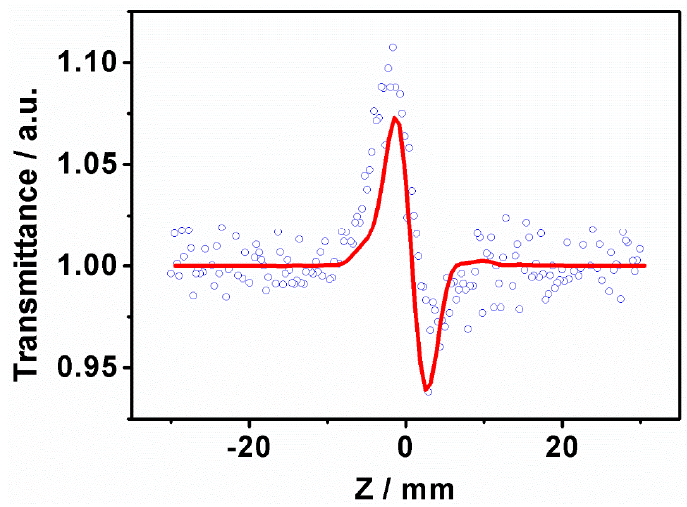
Figure 7. Closed-aperture Z-scan curve of compound PY-C16. Table 2. Third-order nonlinear parameters of compounds.